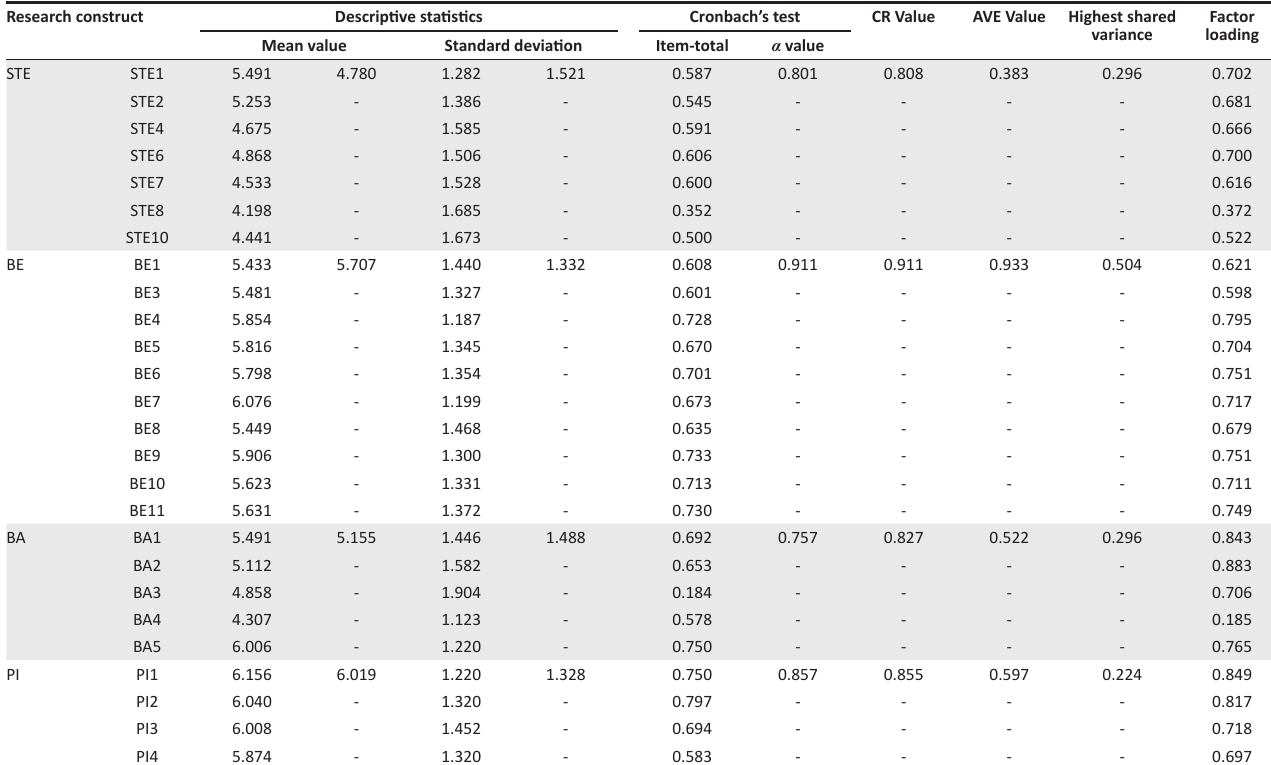
TABLE 2: Accuracy analysis statistics.